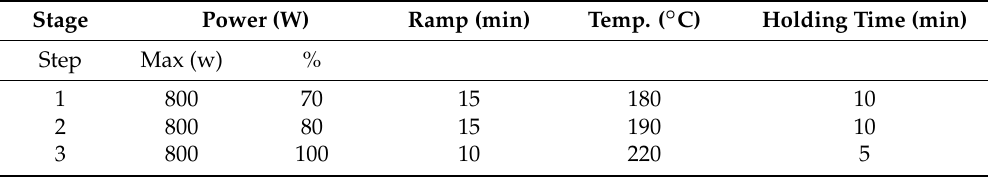
Table 2. Operating conditions for microwave assisted acid digestion system.